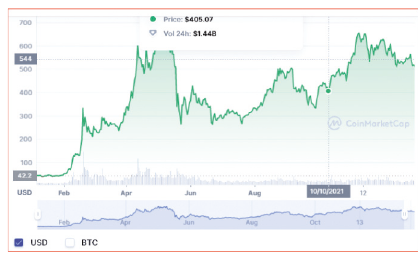
3: 1BNB � 508.32USD (https://coinmarketcap.com/ currencies/bnb/?period � 7d).